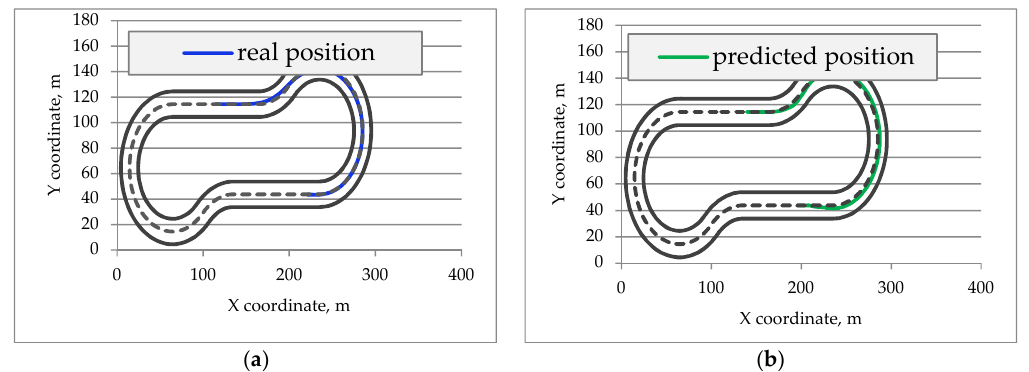
Figure 8. Real trajectory of the car ( a ) and predicted position of the car ( b ). Time of the prediction—1.5 s, µ = 0.1.